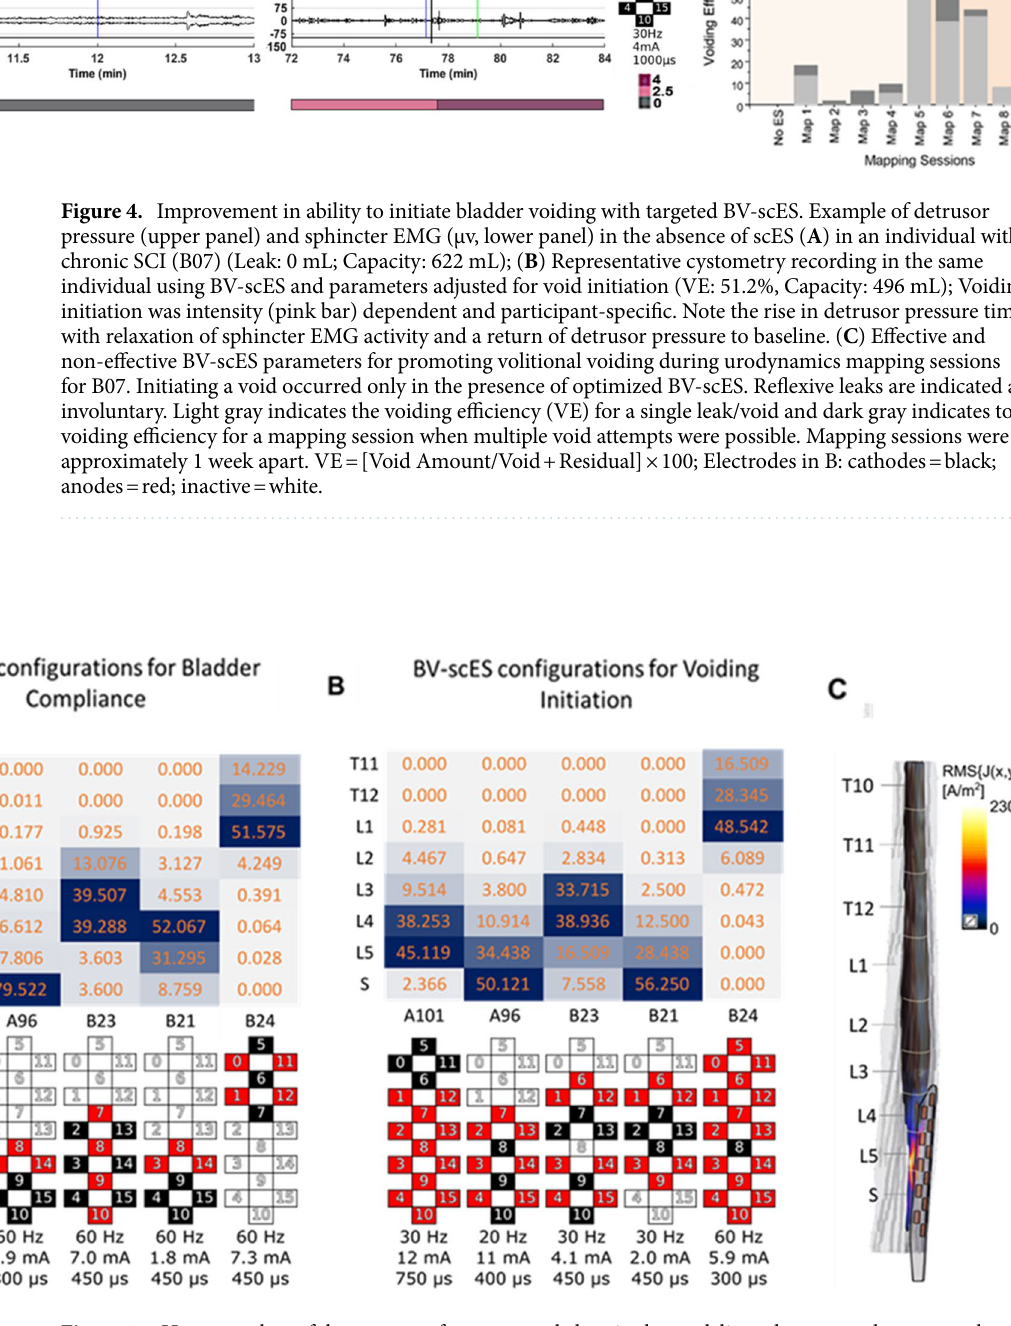
Figure 5. Heatmap plots of the amount of percent total electric charge delivered across each segment that resulted in best bladder storage outcomes ( A ) and bladder voiding ( B ) for each individual (x-axis) and the areas of the spinal cord that were directly targeted by the stimulation (y-axis) as well as the corresponding map configurations (black—cathodes; red—anodes) and stimulation parameters; ( C ) Example of MRI-based 3D model of the spinal cord at lumbosacral enlargement and location of scES paddle electrode with respect to the spinal cord levels. Distribution of electric current density is highlighted with heatmap. Simulations are performed using Sim4Life platform. BC bladder compliance, BV bladder voiding, L lumbar, S sacral, scES spinal cord epidural stimulation, T